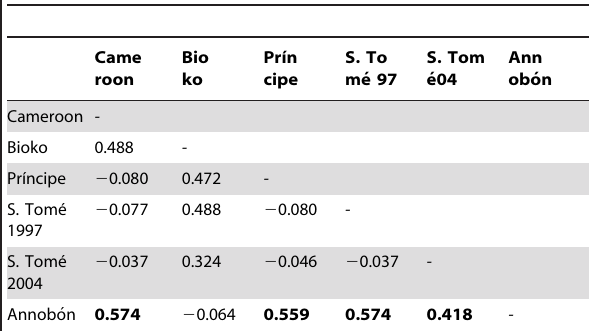
Table 3. Estimates of pairwise genetic differentiation among populations of An. gambiae s.s. in the Gulf of Guinea, based on Herves elements.